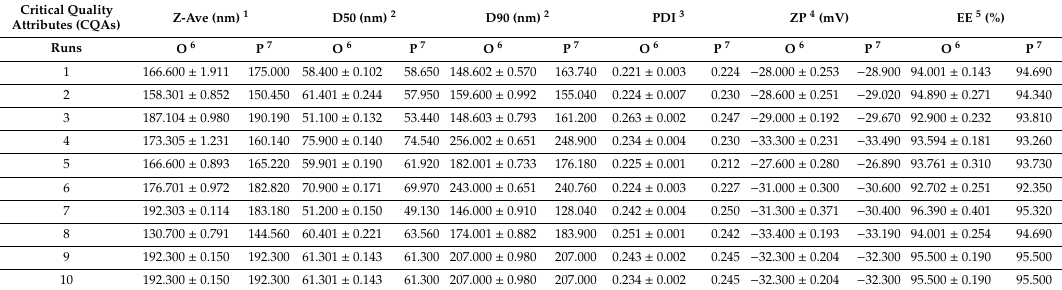
Table 3. Observed (O) and predicted (P) results for critical quality attributes